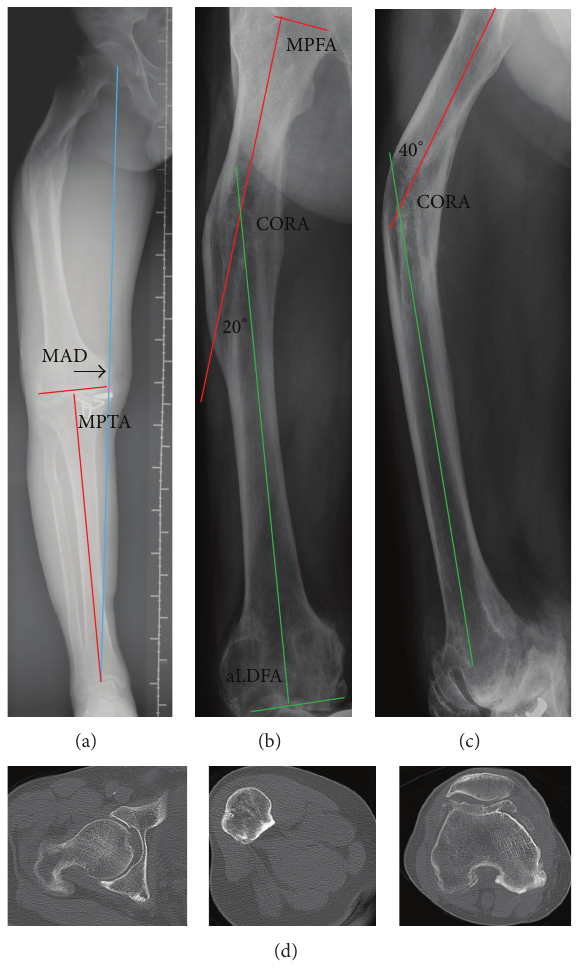
Figure 1: (a) Standing scanogram of the right lower limb. Mechanical axis deviation (MAD) is 5 cm from knee center. Medial proximal tibial angle (MTPA) is 84 ∘ . (b) Anteroposterior X-ray of right femur. Medial proximal femoral angle (MPFA) is 89 ∘ . Anatomical lateral distal femoralangle(aLDFA)is89 ∘ .Lateralangulationatthecenterofrotationofangulation(CORA)is20 ∘ .(c)LateralX-rayofrightfemur.Anterior angulation at CORA is 40 ∘ . (d) Computer tomography of right hip, right femoral shaft at apex of deformity, and right femoral condyle. The femoral neck anteversion is 15 ∘ . The medullary canal is obliterated at the apex of deformity.